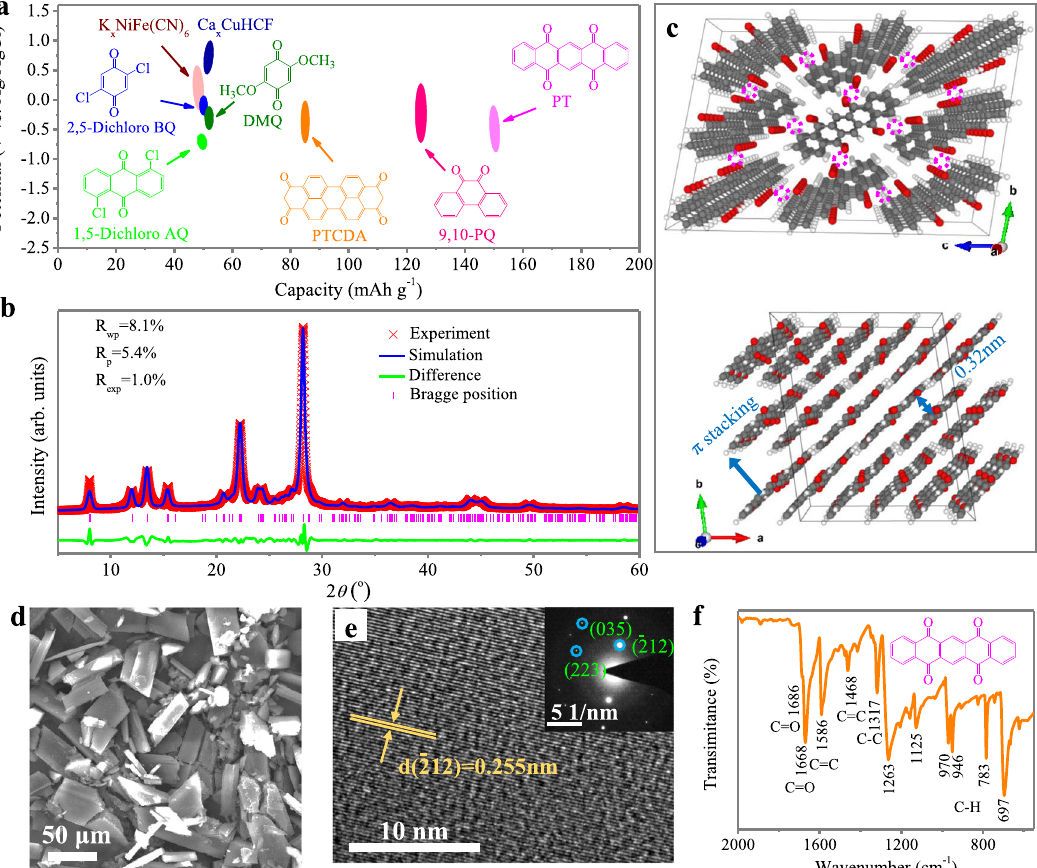
Fig. 1 Comparison of selected aromatic organic molecular crystals and structural characterization of the PT materials. a Discharge/charge voltage ranges and capacities of selected aromatic organic molecular crystals (DMQ, 2,5-dichloro BQ, 1,5-dichloro AQ, 9,10-PQ, PTCDA, and PT in 1M CaCl 2 electrolyte. The typically reported inorganic electrodes including Ca x CuHCF 32 , K x NiFe(CN) 6 33 , are also listed for comparison. b XRD pattern of PT powder (red cross) and the Rietveld-re fi ned XRD pattern (blue line). c Perspective view of a PT supercell observed from a axis and c axis. d SEM image. e HRTEM image and SAED pattern. f FTIR spectrum of PT